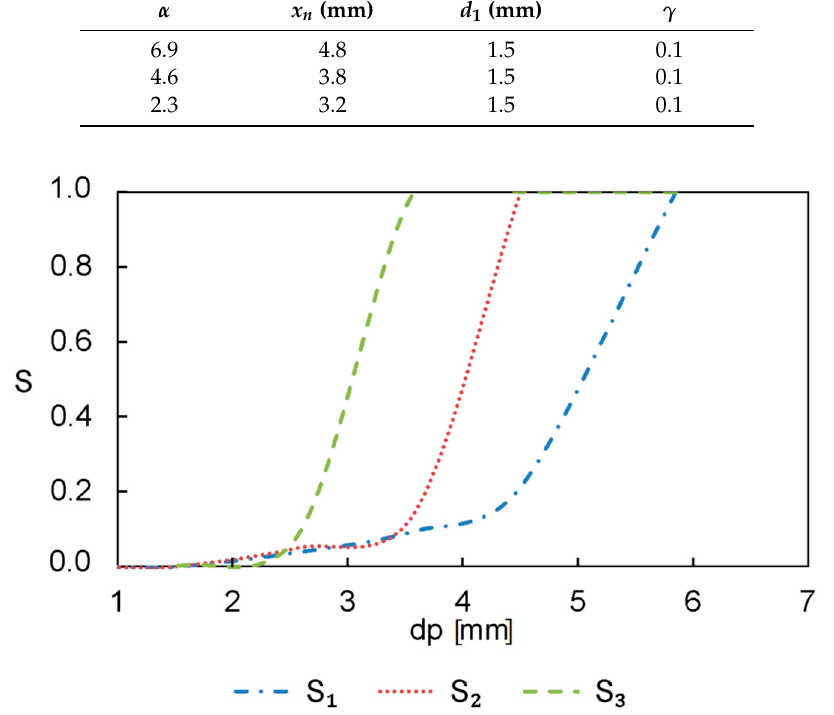
Figure 12. Selection function performance for the PF-1 experiments, using the variables previously calculated (Table 4).